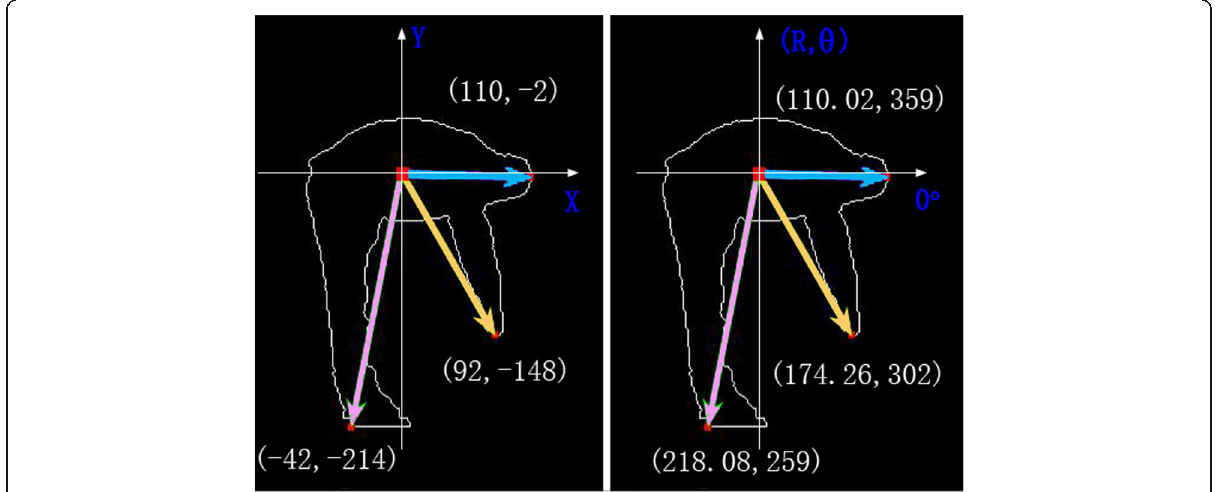
Fig. 11 Transformation of Cartesian coordinate into Polar